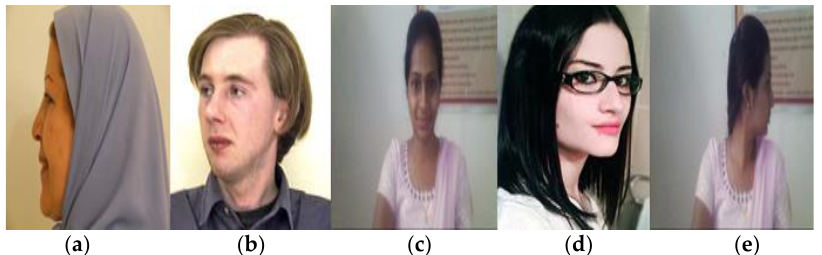
Figure 3. Estimation of the head pose for unknown images for different illumination conditions .